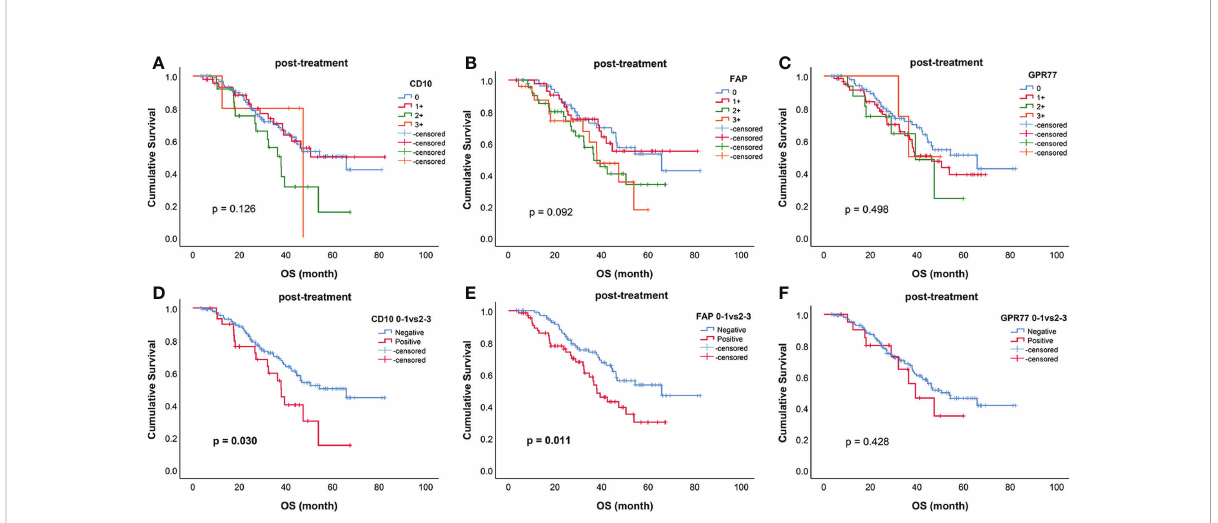
FIGURE 3 Kaplan – Meier curves for overall survival (OS) of biomarkers after treatment. Survival curves for (A) CD10; (B) FAP; (C) GPR77; (D) CD10 (0-1 vs 2- 3); (E) FAP (0-1 vs 2-3); (F) GPR77 (0-1 vs 2-3). CD10 (0-1 vs 2-3) (p=0.030) and FAP (0-1 vs 2-3) (p=0.011) were signi fi cantly related to OS.